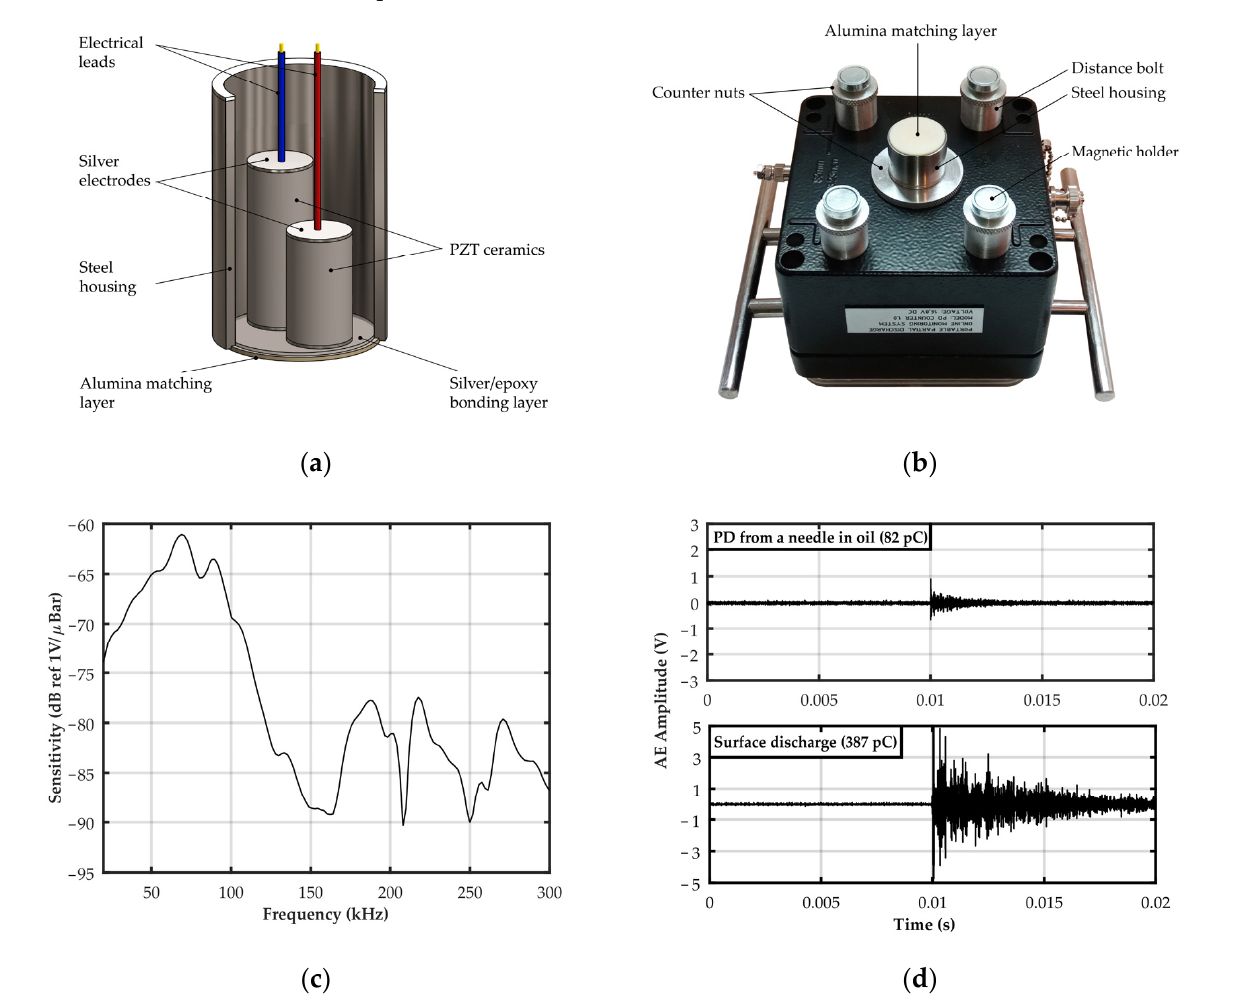
Figure 2. Piezoelectric transducer for detection of AE signals generated by partial discharges: ( a ) schematic diagram of the transducer construction; ( b ) photograph of the monitoring system housing with piezoelectric transducer and magnetic holders; ( c ) frequency response characteristics of the piezoelectric transducer; ( d ) AE waveforms recorded for a PD from a needle in oil with an apparent charge of 82 pC and for a surface discharge on a pressboard sample in oil with an apparent charge of 387 pC.